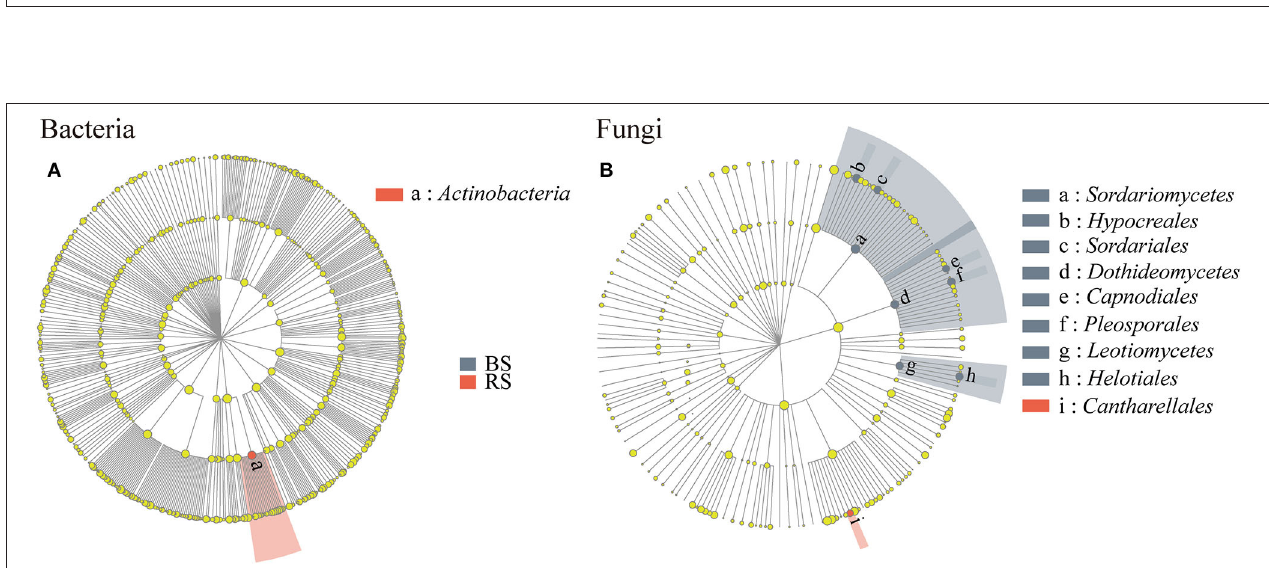
FIGURE 5 | (A,B) LEfSe results in the bulk soil and the rhizosphere soil. Linear discriminant analysis (LDA) was carried out on samples according to different grouping conditions based on taxonomic compositions to identify communities or species that had a significant differential impact on sample delineation. The classification level of tree diagrams is from phylum to order. Node size, the relative abundances of each species. Different colored nodes, microorganisms that are significantly enriched in the corresponding group. Yellowish nodes, no significant differences between groups. LDA > 3.5 and p < 0.05. BS and RS, bulk soil and rhizosphere soil, respectively.